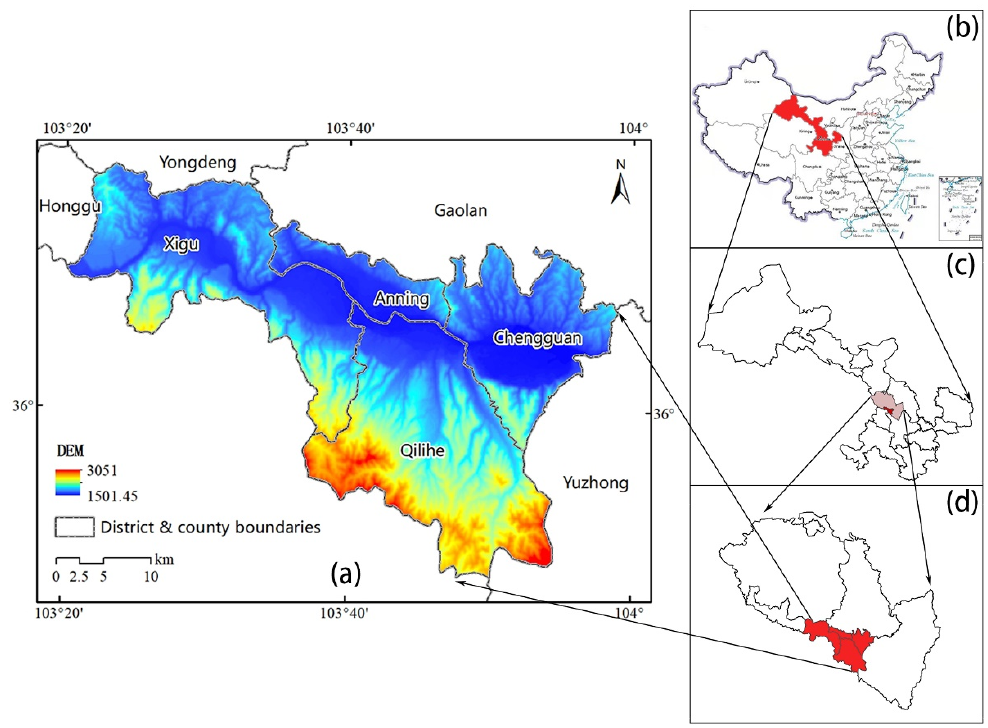
Figure 1. ( a ) Geographic location of the study area showing the elevations of Chengguan, Anning-Qilihe, and Xigu central areas. Inset maps show ( b ) the location of Gansu Province within China; ( c ) the location of Lanzhou within Gansu Province; ( d ) the locations of these central areas within